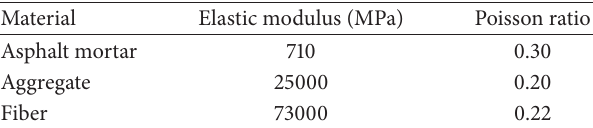
Table 1: Elastic properties of different